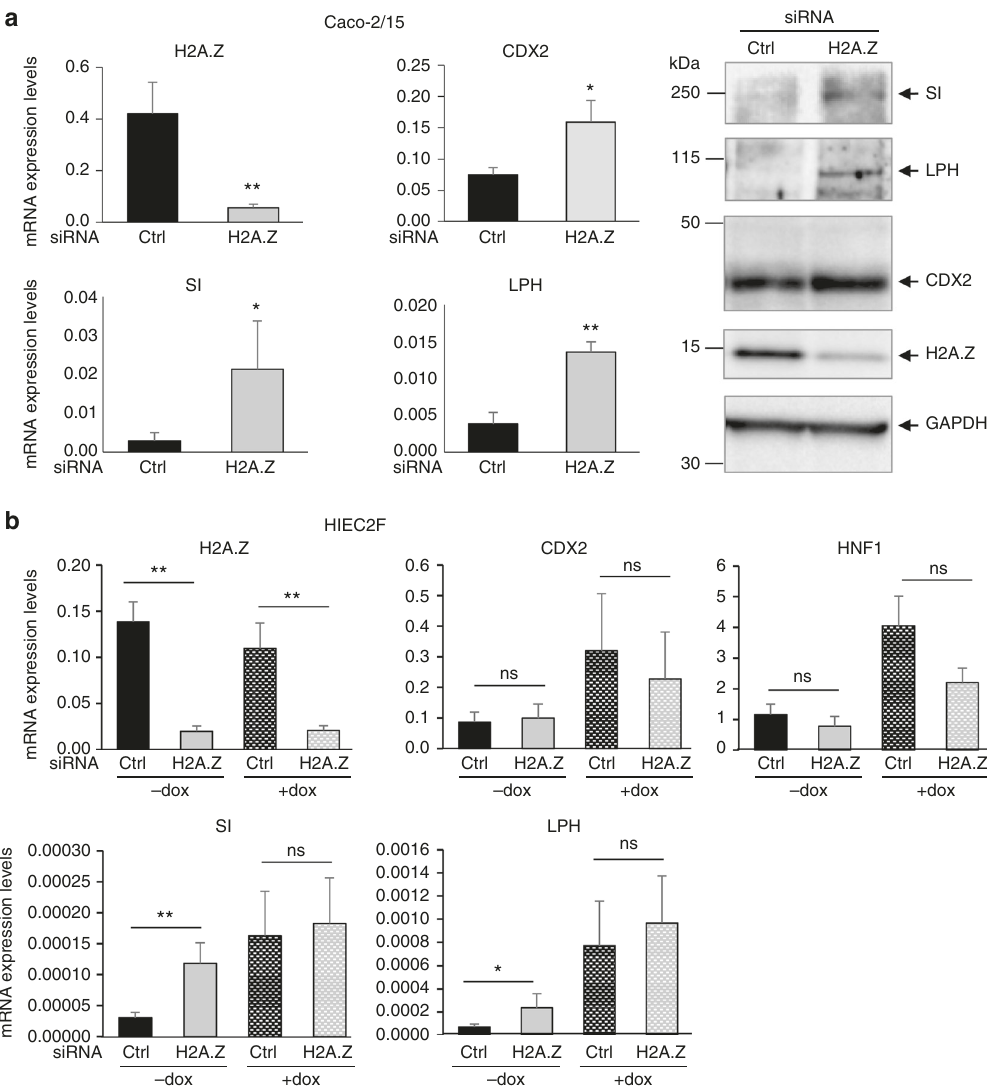
Fig. 2 Negative control of differentiation marker expression by H2A.Z. a Caco-2/15 cells were transfected using siRNA targeting H2A.Z or control. 72 h later, total RNA was extracted and subjected to RT-qPCR analysis for the expression of the indicated genes (calculated relative to β 2m mRNA level). The mean and standard deviation are shown ( n = 5 independent experiments). Statistical analysis was done using the Student ’ s t -Test (* p < 0.05; ** p < 0.02 vs control siRNA). Also shown is the expression of the corresponding proteins analyzed by western blot from total extracted proteins of the same samples. b HIEC2F cells were transfected using siRNA control or targeting H2A.Z, and treated or not with 10 µ g/ml doxycycline for 3 days. Total RNA was extracted and RT-qPCR analysis for the expression of the indicated genes was performed as in